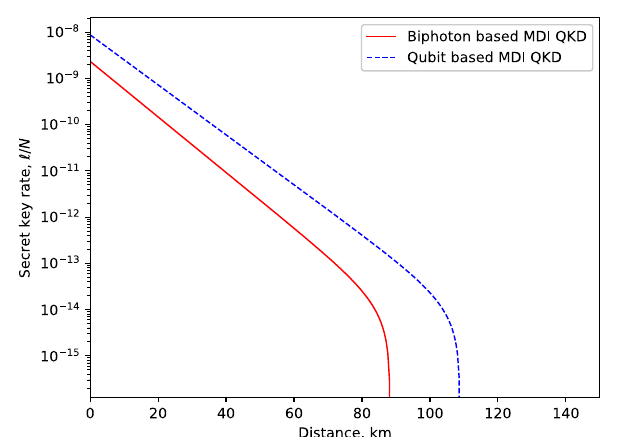
10 12 , N 10 13 , N 10 14 and N 10 16 . = = = =